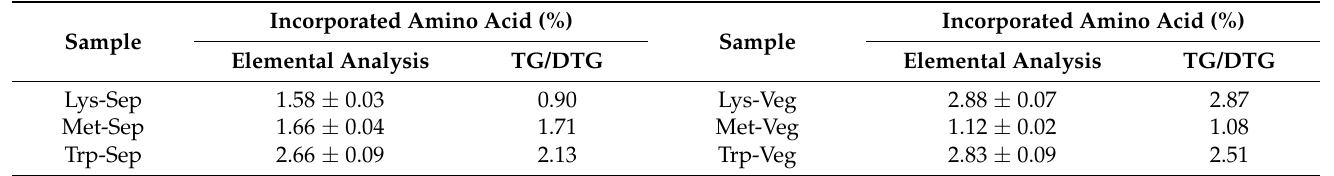
Table 5. Amounts of incorporated amino acid obtained from elemental analysis and thermal analysis